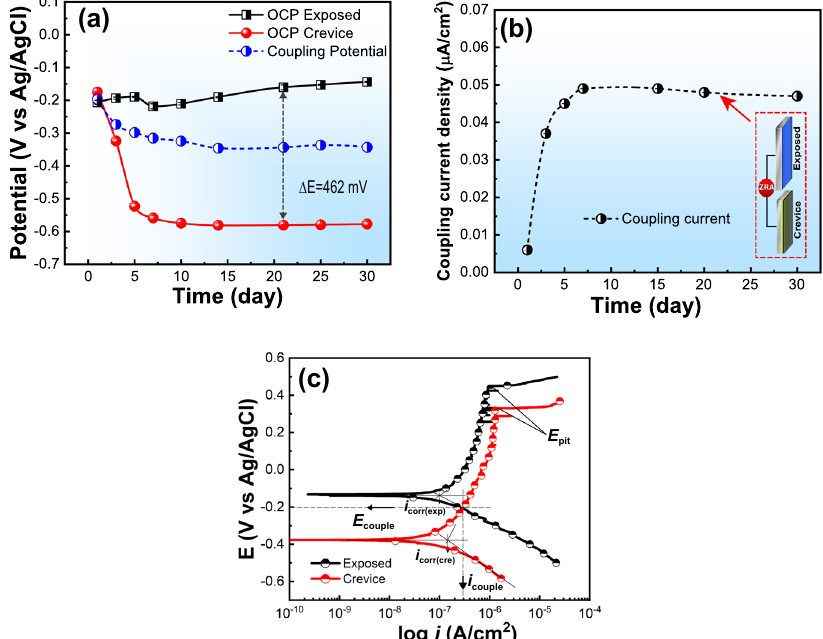
Fig. 7 Potential, galvanic and kinetic data. a Time-dependent plots of the OCP recorded at the exposed and crevice surfaces and their coupling potential, b average current density vs. time pro fi le of the crevice/exposed galvanic couple, c polarization